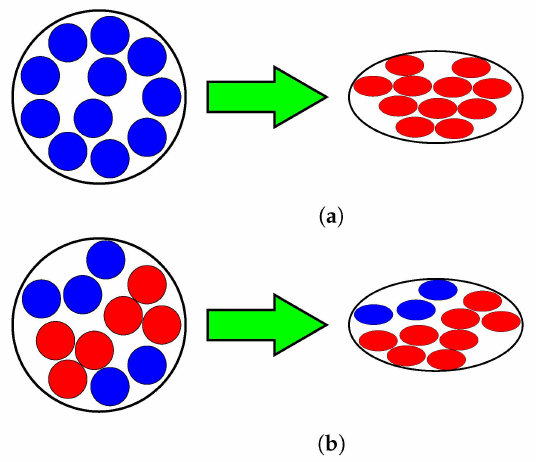
Figure 18. Rearrangement of fibres within the conductive thread used. ( a ) Initial position of the fibres. Each blue dot represents a fibre that is not in contact with neighbouring ones. When the sensor is stretched, the cross-sectional area of the conductive thread decreases, which increases the total number of fibres that touch each other (red dots). ( b ) Position of the fibres within the conductive thread after unstretching the sensor. Some of these fibres remain in contact with their neighbouring ones, which decreases the overall resistance of the sensor and its working range. When stretching the sensor consecutive times, some of the fibres stop contacting each other, which affects the ability of the sensor to detect changes in